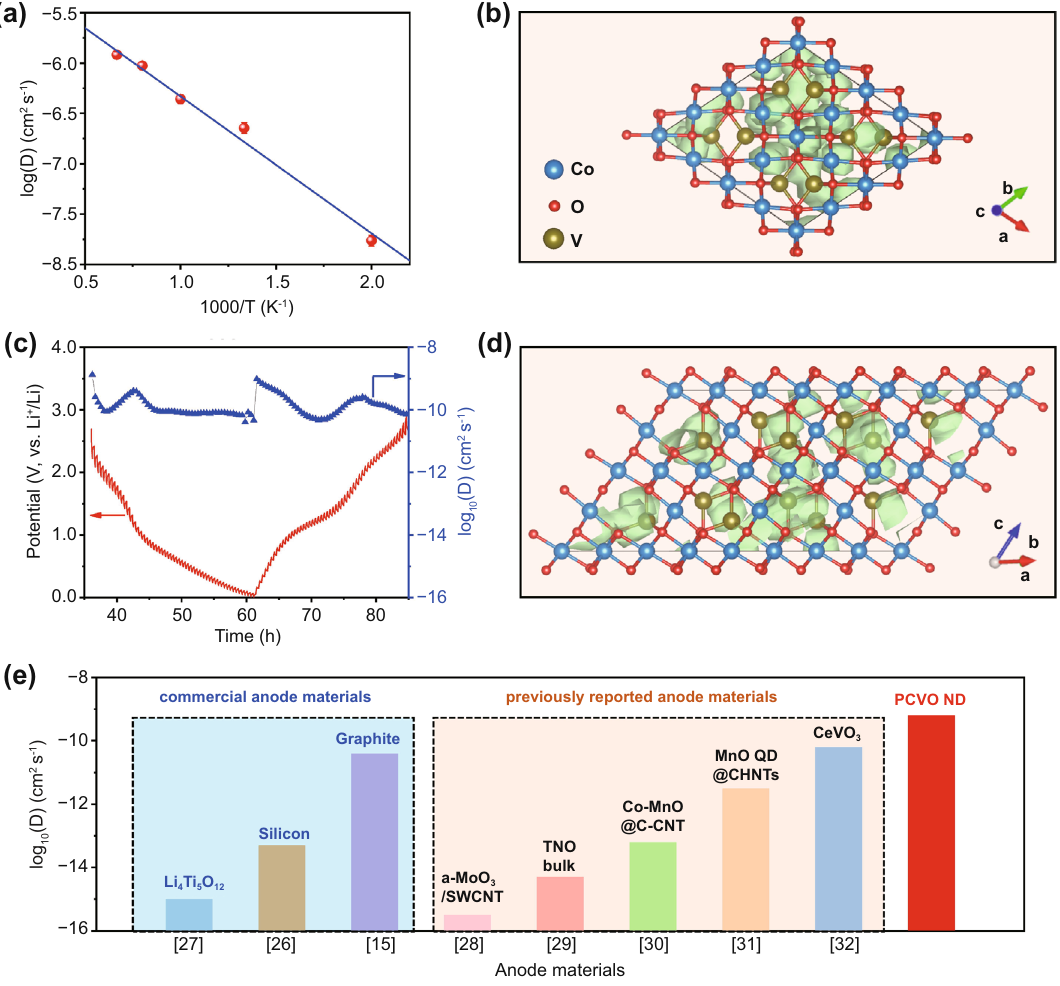
Fig. 2 a Arrhenius plot of overall diffusion coefficient, where the error bar corresponds to statistical uncertainty in the fitting of the mean square displacement to time curve. b Top view and d side view of isosurfaces of lithium ion probability density during an AIMD simulation. c GITT curve and corresponding Li + diffusion coefficient of PCVO ND. e The comparison of Li + diffusion coefficient of PCVO ND with commercial anode materials and other previously reported anode